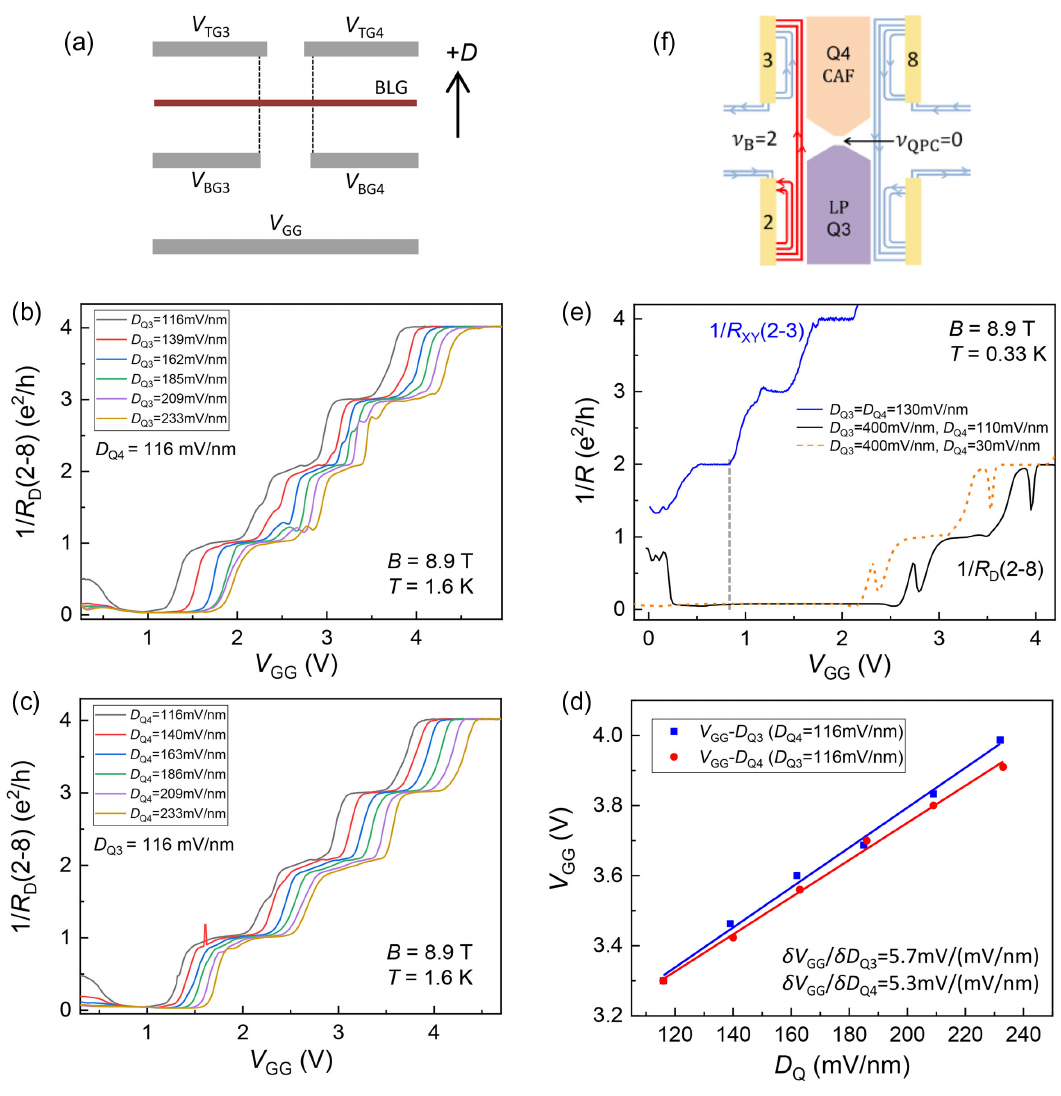
FIG. 8. (a) illustrates the misalignment of the top and bottom gates forming the QPC in device 606. The positive slopes in (d) indicate ð 2 – 8 Þ versus V ¼ 116 mV = nm. (c) 1 =R ð 2 – 8 Þ versus V that both top gates extend into the opening. (b) 1 =R at varying D . D Q 3 Q 4 D GG D GG ¼ 116 mV = nm. Tracking the shift of the ν ¼ 3 plateau allows us to obtain the relation between V at varying D . D and either D Q 4 Q 3 Q 3 GG ð 2 – 8 Þ vs V ¼ 110 mV = nm and D ¼ 400 mV = nm (black trace). Also plotted or D . The results are plotted in (d). (e) 1 =R at D Q 4 Q 4 Q 3 D GG ¼ 400 mV = nm, is 1 =R in the bulk (blue trace) for reference. In the majority of our nonlocal measurements, we set D XY Q 3 ¼ 30 mV = nm, and V ¼ 0 . 8 V. In this configuration, the bulk is at ν ¼ 2 , Q 3 is in the LP phase, and Q 4 is in the CAF phase. D Q 4 GG B ¼ 110 mV = nm by − 0 . 42 V We obtain the expected QPC conductance (orange dashed trace) by shifting the measurement at D Q 4 according to the gating relation in (d). It shows that the QPC opening sits squarely on the ν ¼ 0 plateau. (f) illustrates the filling factor of different areas and edge states flow in this